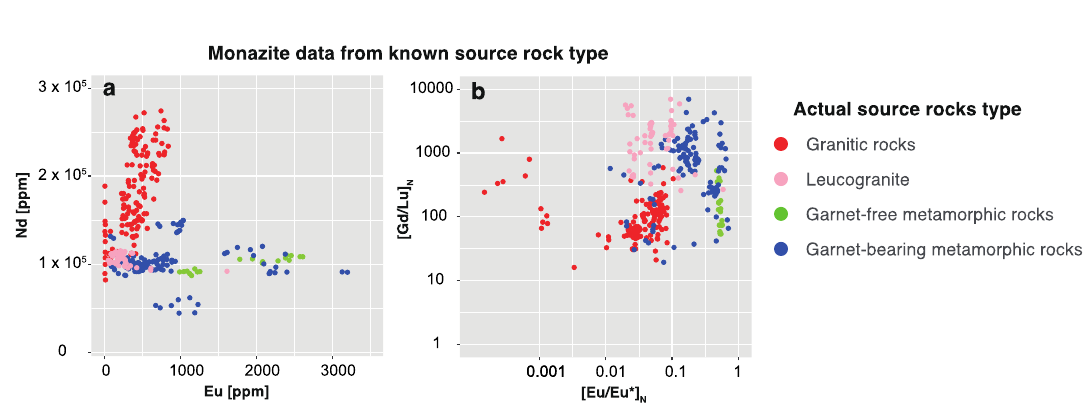
Table 1. Geochemical criteria for monazite source rock type based on the Eu anomaly and relative depletion of heavy-to-middle rare earth elements.